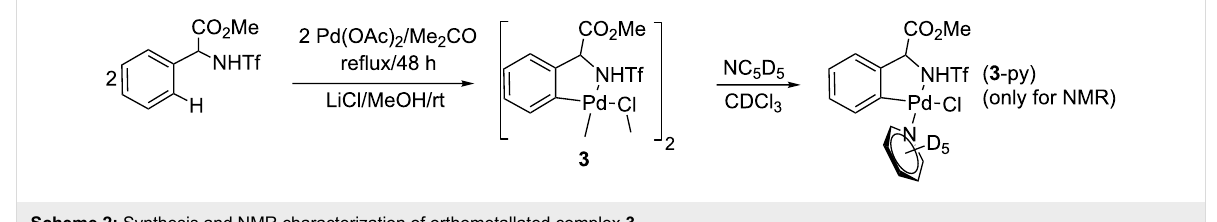
Scheme 2: Synthesis and NMR characterization of orthometallated complex 3